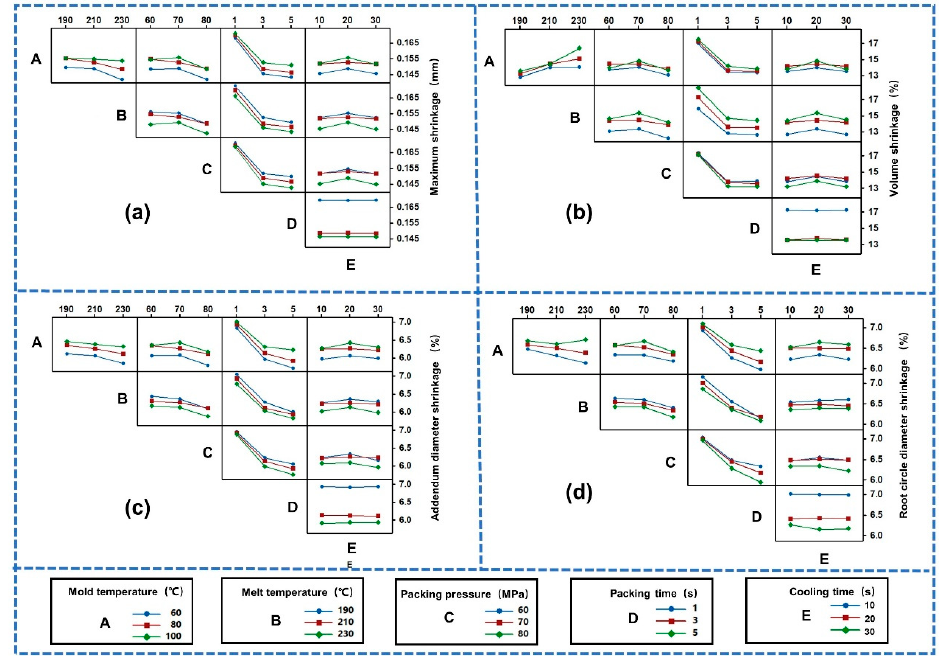
shrinkage ( 𝑌 (cid:2872) ) calculated according to Figure 12c were 5.618% and 5.762%, which were